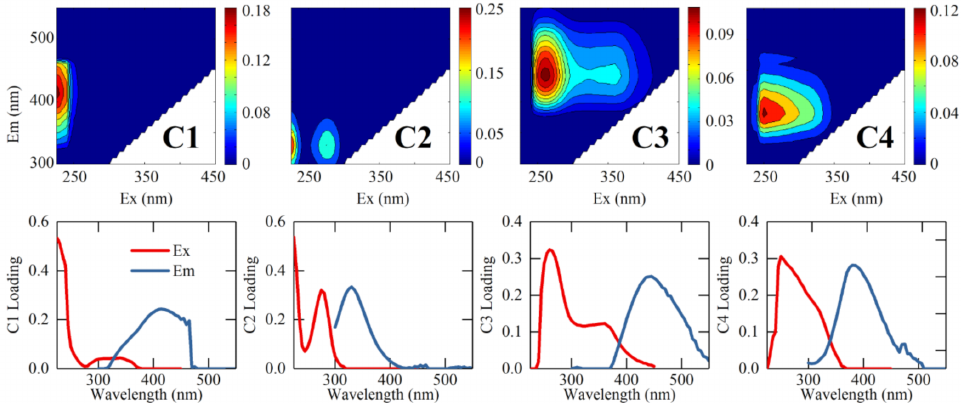
Figure 3. Contour plots of the four components identified by PARAFAC analysis (lower panel) and the locations of Emission (Ex) and Excitation (Ex) spectra of each component (upper panel). Component 2, with the Ex/Em wavelengths of <250(275)/330 nm, resembles